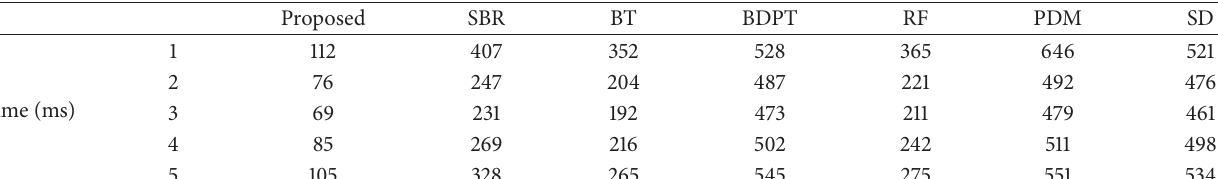
Table 5: Combined results for all five environments.